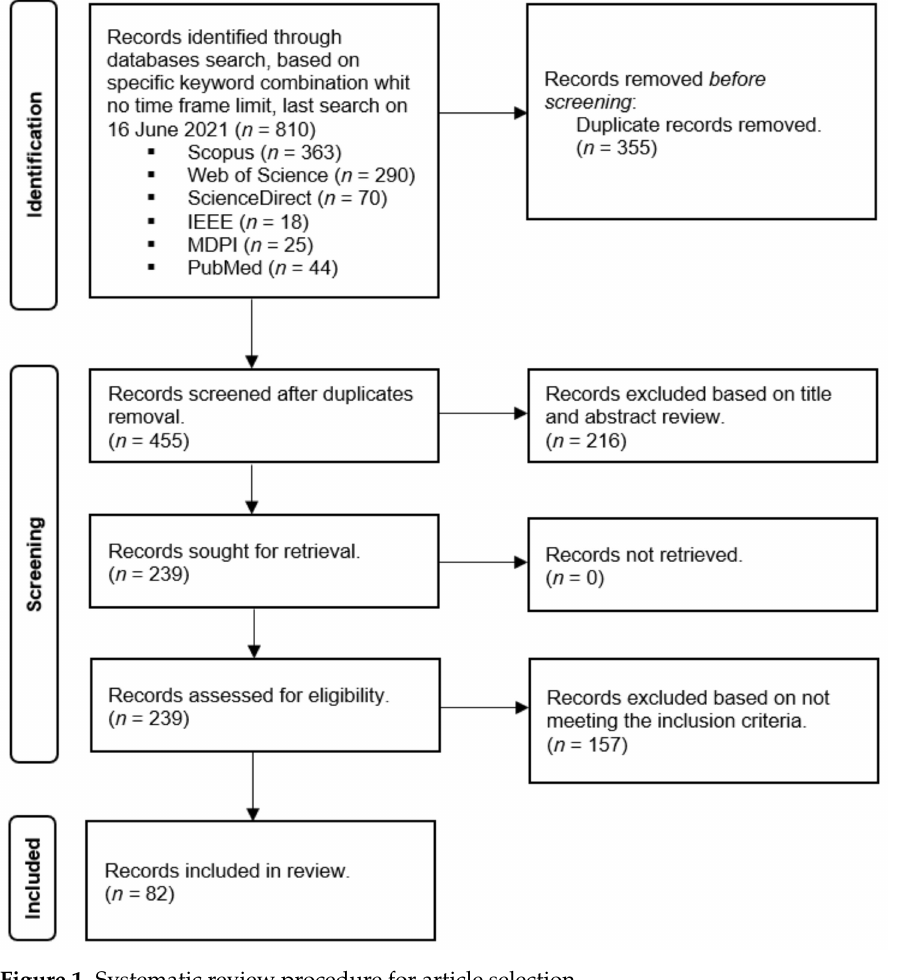
Figure 1. Systematic review procedure for article